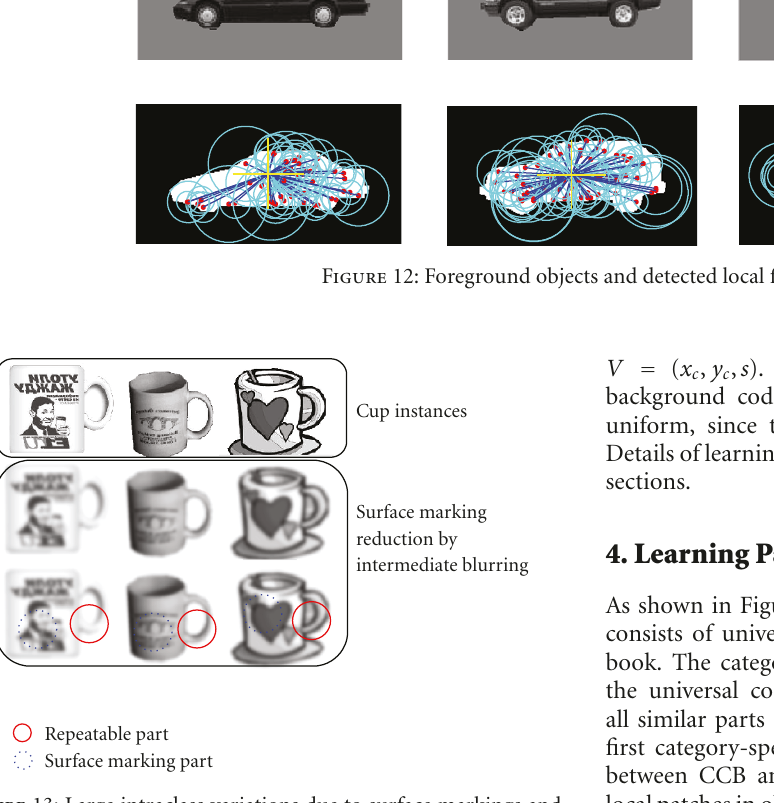
Figure 13: Large intraclass variations due to surface markings and reduction strategy during codebook